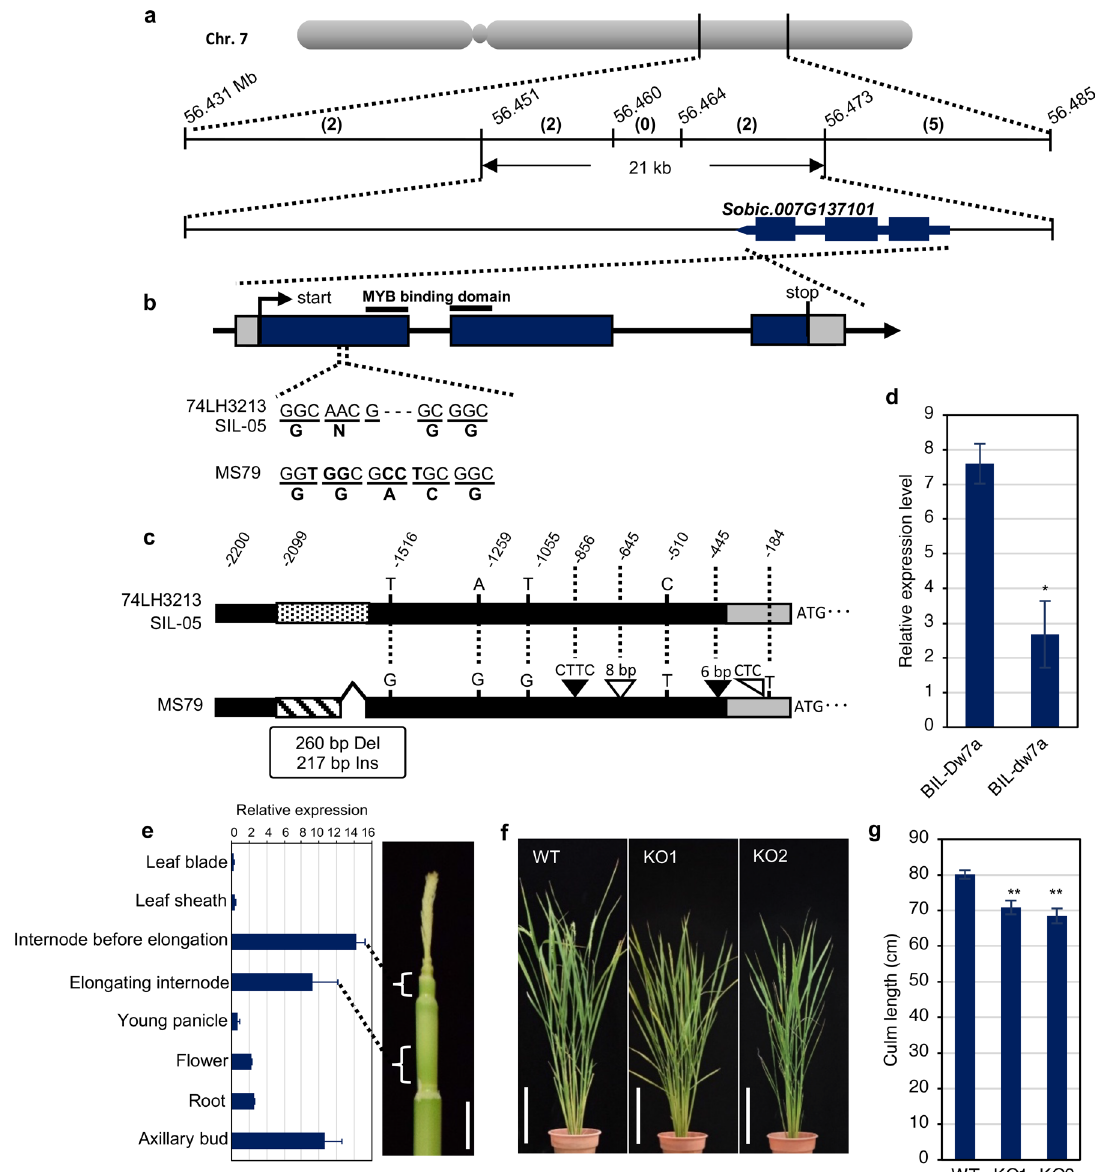
Figure 5. Positional cloning of Dw7a and phenotypes of the CRISPR/Cas9 mediated knock-out lines of OsDw7a in rice. ( a ) Physical position of Dw7a (corresponding gene of qCL-7a ). The uppermost grey bar indicates chromosome 7. On the upper horizontal line, the vertical lines indicate the physical positions of the DNA markers (Mb), and the number of recombinants is shown in parentheses between the markers. The bottom horizontal line represents the candidate region of 21 kb. Exons are represented as black boxes. ( b ) Gene structure of Dw7a (Sobic.007G137101). Exons are represented as dark blue boxes and the 3 ʹ or 5 ʹ -untranslated regions (UTR) are indicated with grey boxes. The bold lines indicate the R2R3 MYB binding domain. ( c ) Four SNPs (indicated by nucleotides), three In/Dels (black/white triangles, respectively), genomic fragment substitution (260 bp to 217 bp; striped bar) in the promoter region (dotted and striped bares), and one SNP and one deletion in the 5 ʹ -UTR region (grey bar) are shown. ( d ) The expression levels of the Dw7a in the BIL- Dw7a and BIL- dw7a (two-tailed Student’s t -test, * P < 0.05, n = 3). ( e ) The expression levels of Dw7a (in cultivar SIL-05) in different organs. Scale bar in the photograph = 2 cm. The positions of the two internodes ‘before elongation’ and ‘elongating’ are shown in the photograph. ( f ) Phenotype at the heading stage of the WT and two knockout lines. Scale bar = 20 cm. ( g ) Length of each internode of the WT and knockout lines (two-tailed Student’s t -test, ** P < 0.01, n =